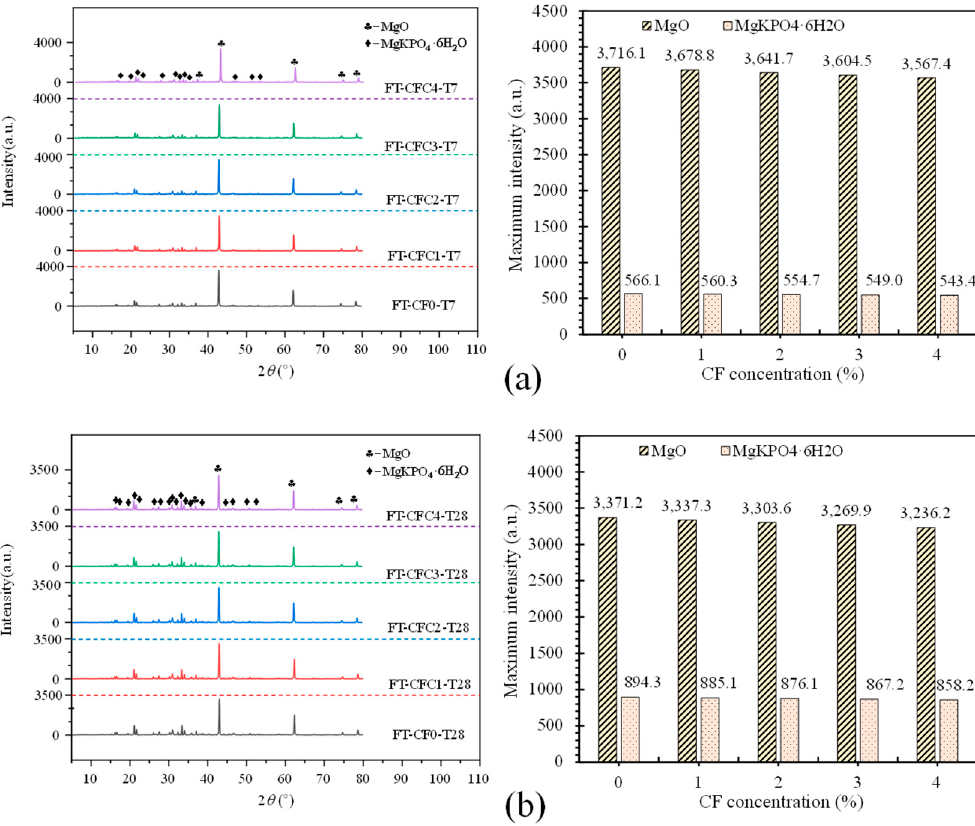
Figure 22. XRD results for specimens: ( a ) T7; ( b ) T28.